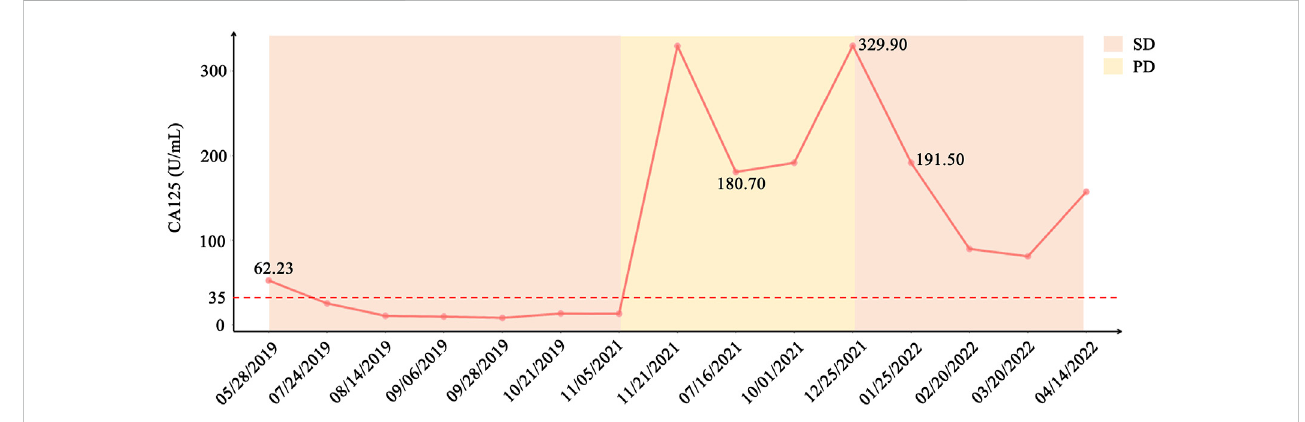
FIGURE 4 Variation in CA125 and status of the patient from initial treatment to current treatment. CA125 level decreased sharply after treatment with anlotinib in May 2019 and treatment with PARPi combined with pebolizumab in December